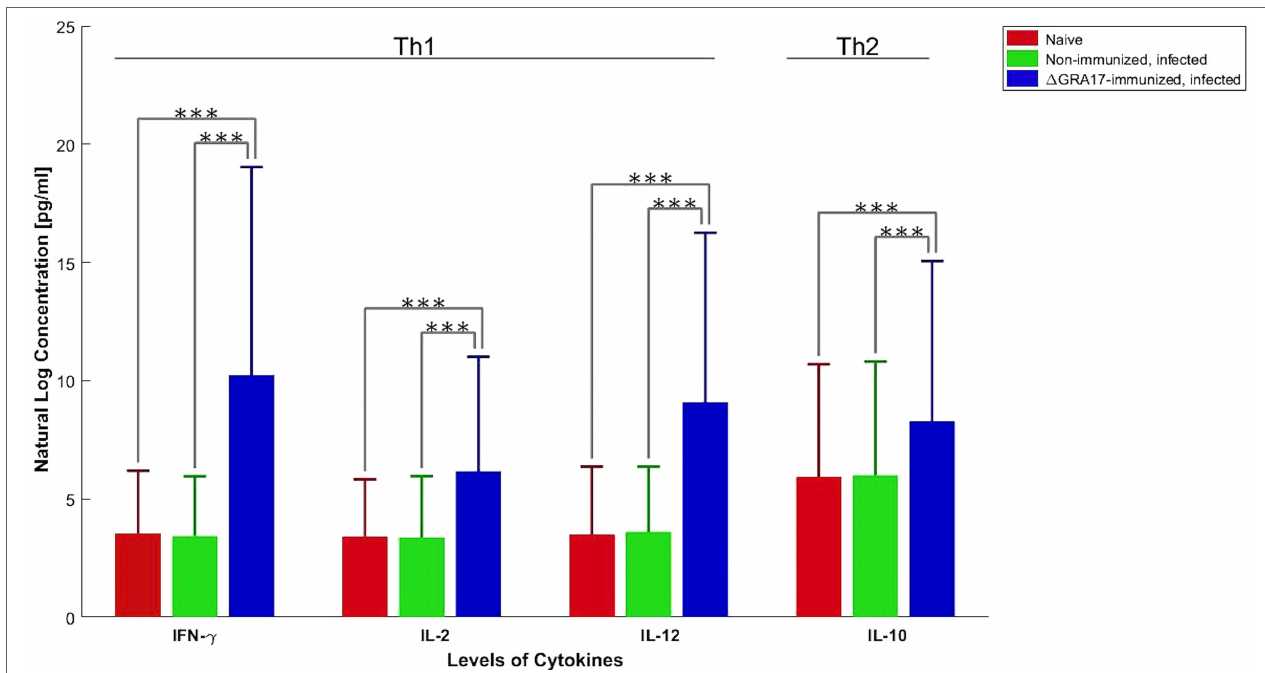
FigUre 12 | Production of Toxoplasma gondii -specific Th1 and Th2 cytokines in GRA17 -immunized mice after infection with Pru cysts on day 12 of gestation. Immunized, pregnant mice were infected with T. gondii Pru cysts 12 days of gestation and spleen cells were collected 6 days after infection. Splenocyte culture was stimulated in vitro with T. gondii soluble tachyzoite antigen (10 µg/ml). Cell-free supernatants were harvested and evaluated for interleukin-2 (IL-2), IL-10, IL-12, and INF- γ . Cytokine concentrations represent mean ± SD after subtraction of background control values with medium only. Significance compared with uninfected and non-immunized (naïve) mice: *** p <